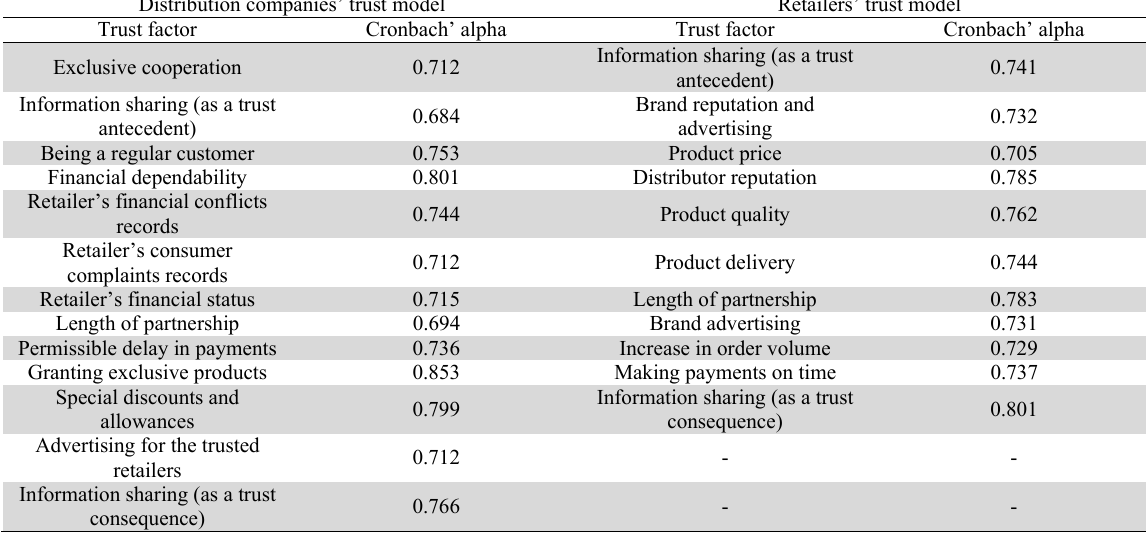
The values of Cronbach’ alpha for the collected